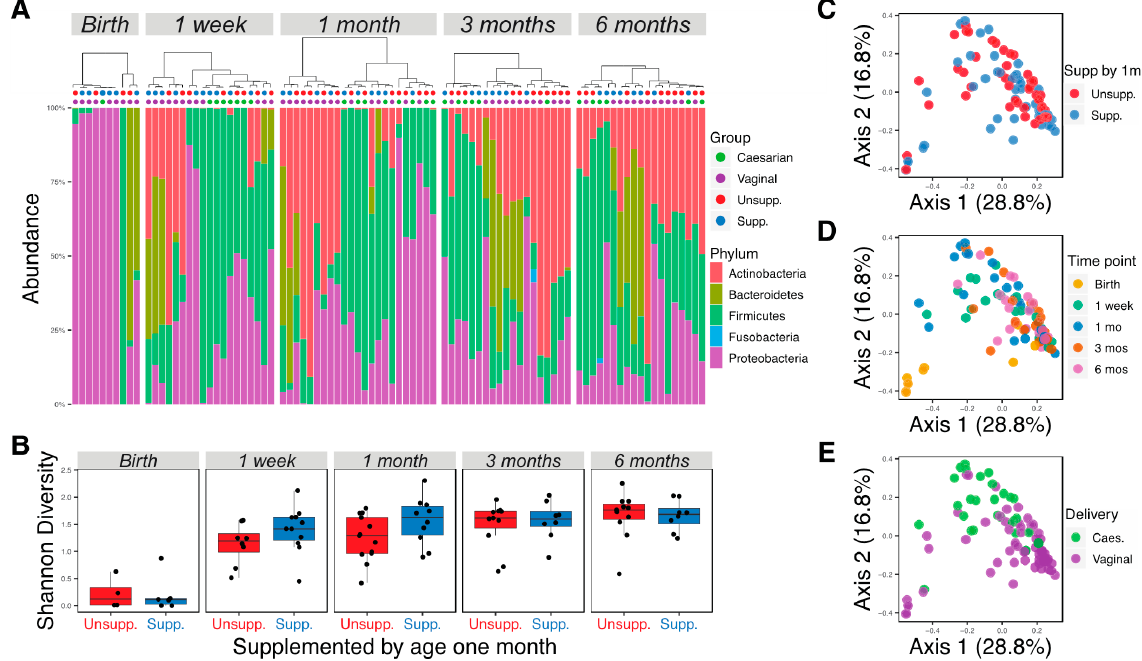
Figure 1. Microbial community diversity increased with age and differed according to supplementation and delivery method. ( A ) Relative abundance of bacteria at the phylum level of all infants at different time points. Samples were ordered using weighted UniFrac distance and Ward D clustering method. Colored dots topping each column indicate whether the infant was delivered through cesarean or vaginally; and if unsupplemented or unsupplemented by one month of age. ( B ) Shannon diversity of infant microbiotas at different time points. ( C ) PCoA plot generated using weighted UniFrac distance, colored by diet difference at the age of one month. ( D ) PCoA plot generated using weighted UniFrac distance, colored by time point. ( E ) PCoA plot generated using weighted UniFrac distance, colored by delivery method. Unsupp.: unsupplemented; Supp.: